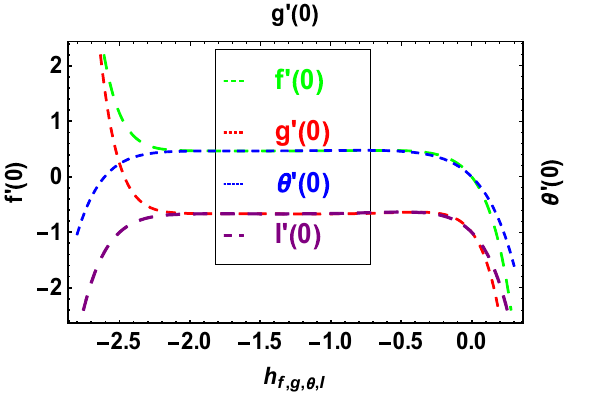
Figure 1. (cid:31) - curves for f ′ ( 0 ) , g ′ ( 0 ) , θ ′ ( 0 ) and I ′ ( 0 ) .